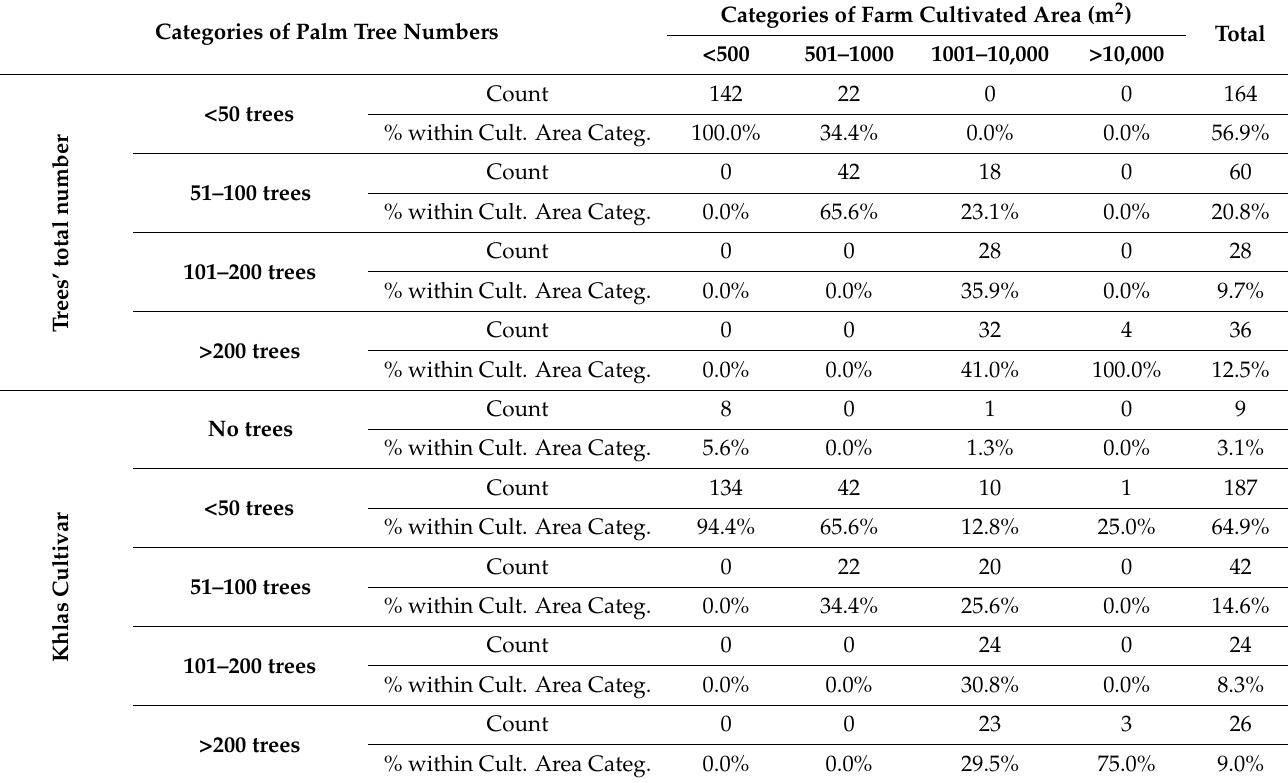
Table 1. Cross-TAB categorical correlation between cultivated area and palm tree